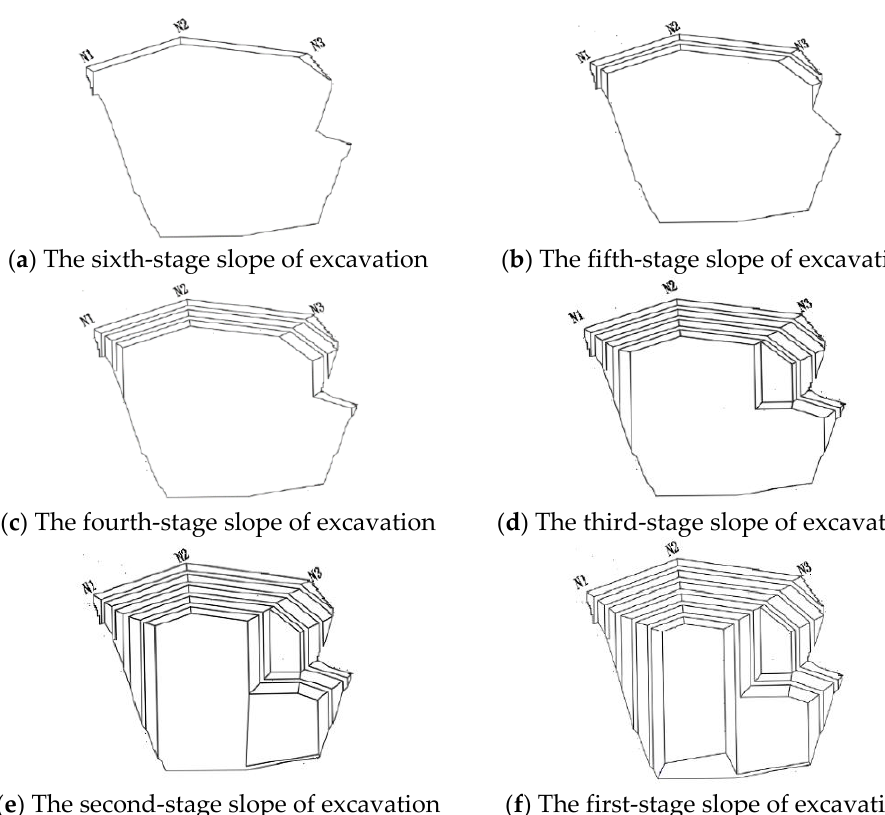
Figure 4. The sequence of the designed excavation.